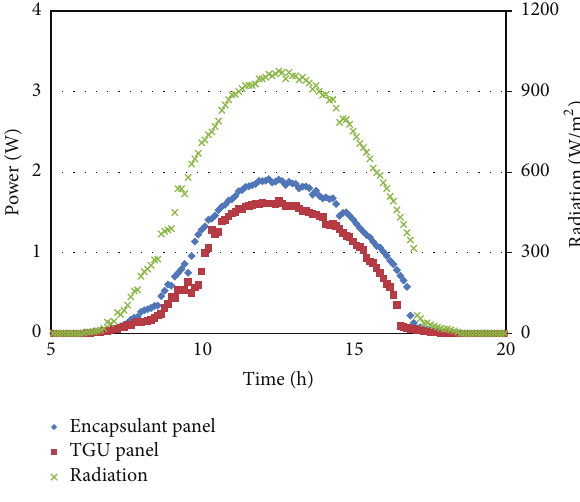
Figure 10: Electricity generation of the panels.